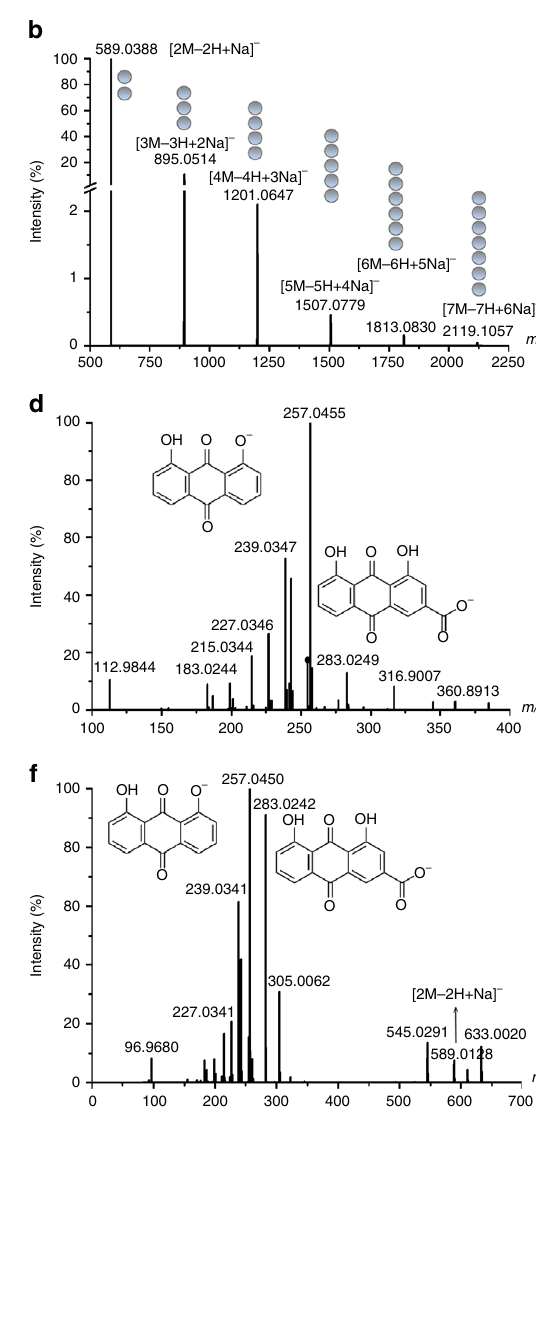
effects on these two cytokines. We tested the rhein hydrogel in a mediators. TNF- α and IL-1 β have been recognized as the key therapeutic setting in LPS-stimulated BV2 cells. LPS led to factors in neuroin fl ammation. Microglia cells are primed by the marked accumulation of TNF- α and IL-1 β compared to the neuroin fl ammatory disorders to produce exaggerated responses control (Fig. 5). After 24 h treatment, the hydrogels and the to IL-1 β and TNF- α 45 . Thus, we primarily focused on the drug NATURE COMMUNICATIONS|